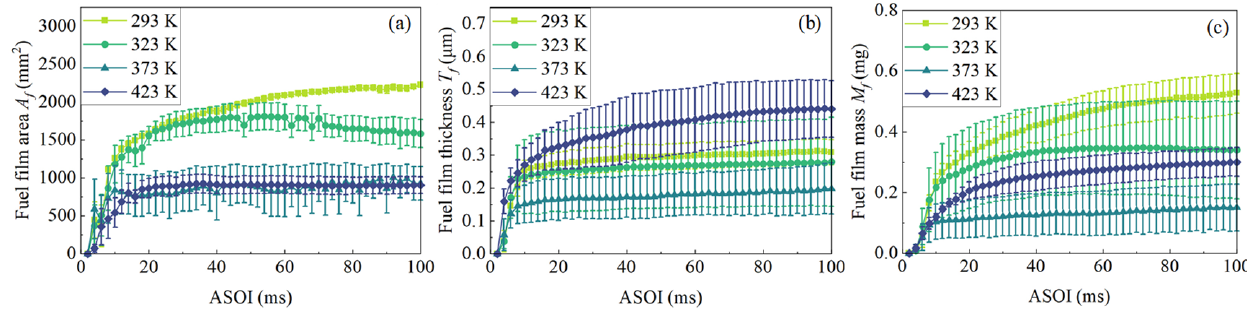
Figure 16. ( a ) Fuel film area A f , ( b ) Fuel film thickness T f and ( c ) Fuel film mass M f on the wall under different T wall